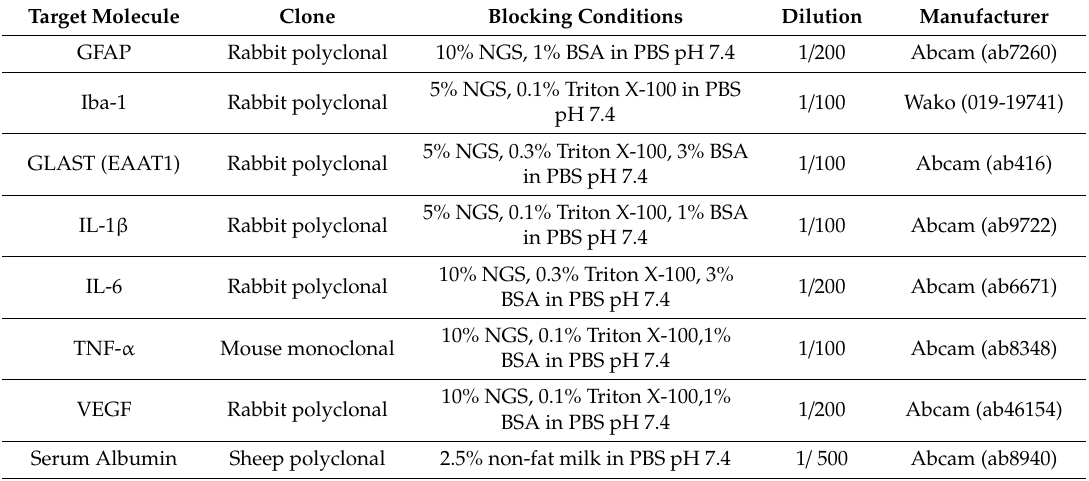
Targets, dilution, blocking conditions and sources of applied primary antibodies in